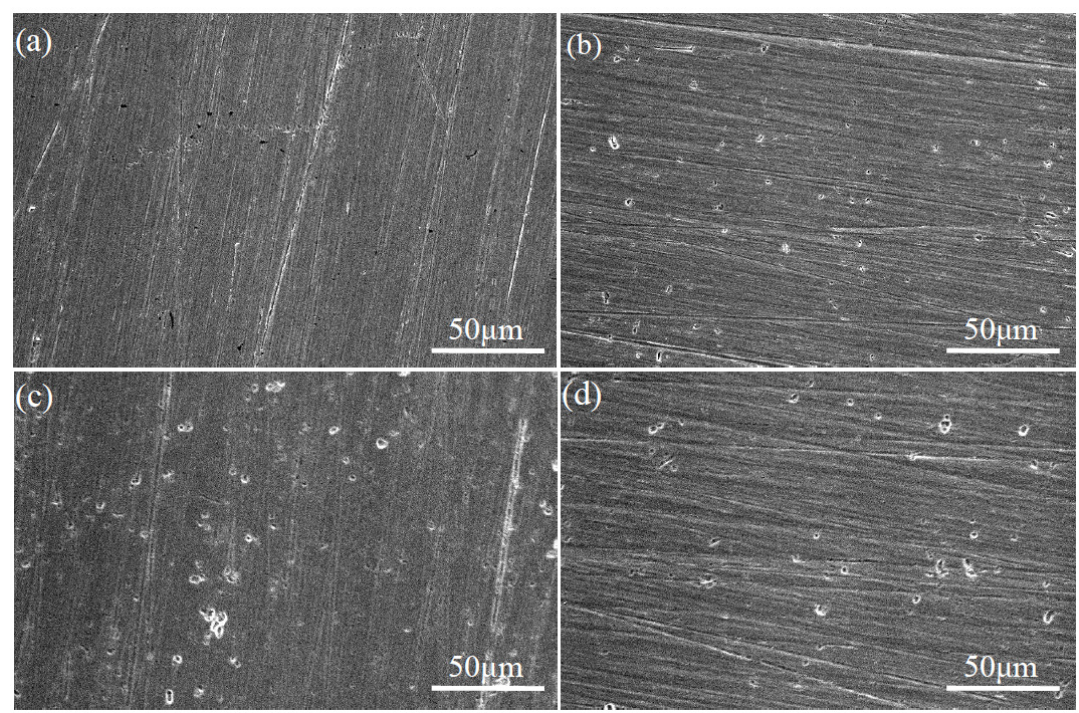
Figure 12. The corrosion morphology of SLM TiNi samples in ASS with different pH and F − concentration. ( a ) pH 4 without F − ; ( b ) pH 4 0.2% F − ; ( c ) pH 4 0.5% F − ; ( d ) pH 5 0.5% F −